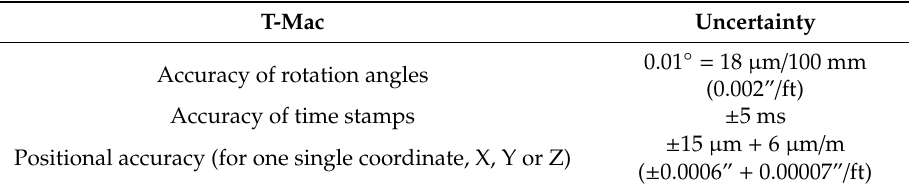
Table 2. Measurement uncertainties of the T-Mac